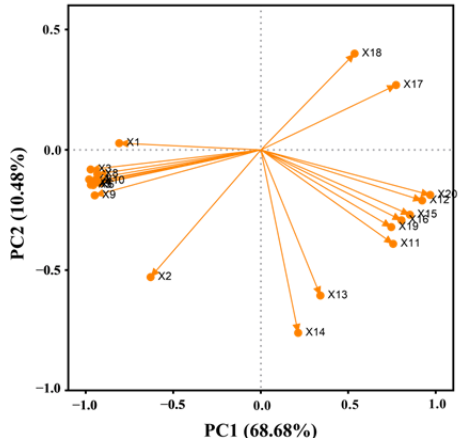
Figure 11. PCA analysis of seed germination and physiological indices of rice under high tempera- ture stress and concentrated melatonin treatment. X1: germination potential; X2: germination